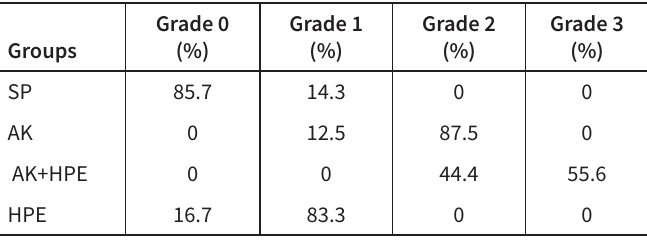
Table 2. Histopathological Grades of the Groups (Percentages of Proximal Tubules) Groups